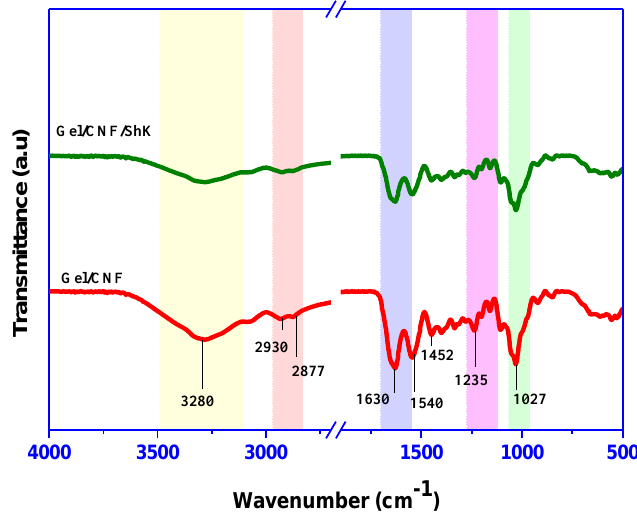
Figure 4. FTIR spectra of the smart films.